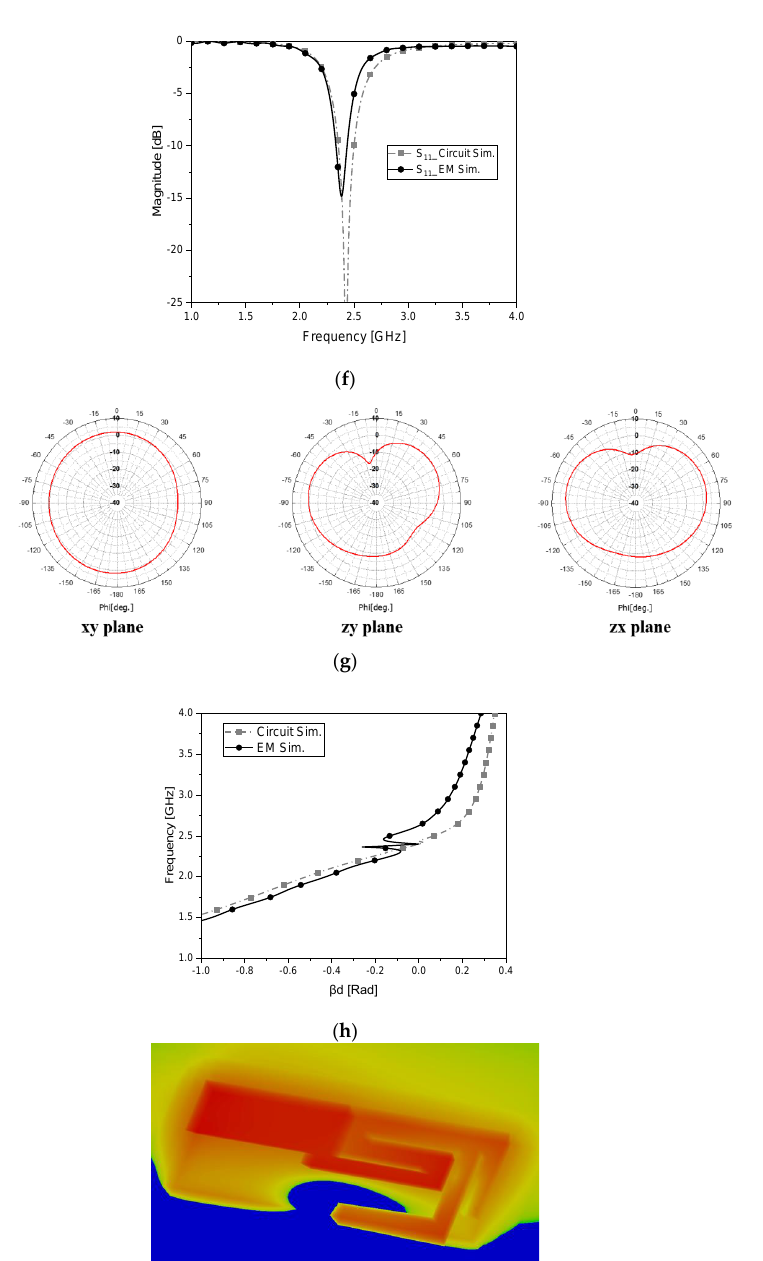
Figure 4. Antenna structure, its EM-simulated frequency-response and metamaterial characteristics. ( a ) Geometrical form in 3D; ( b ) top-view (left) and bottom view (right); ( c ) S 11 of the antenna; ( d ) S 11 of the antenna for different L_T10; ( e ) S 11 of the antenna for different W_T2; ( f ) S 11 of EM simulation and circuit simulation; ( g ) far-field patterns on xy-, zy- and zx-planes showing the omni-directional effect; ( h ) dispersion diagram of the antenna, ( i ) zeroth-order resonance E-field